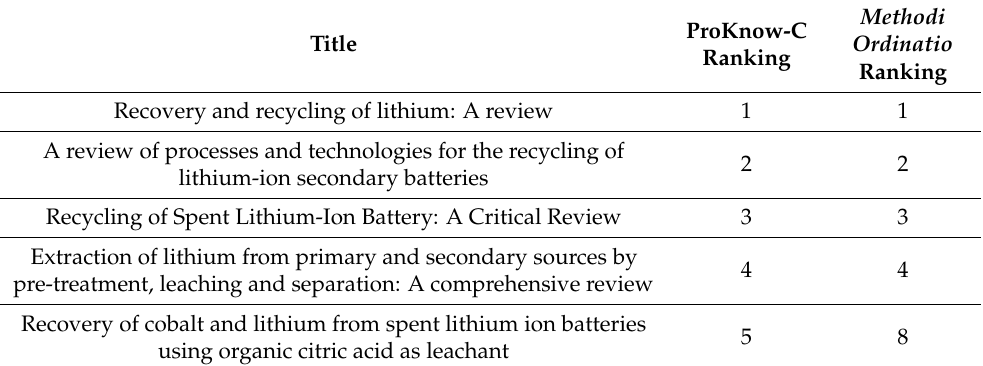
Table 6. Rank comparisons between ProKnow-C and Methodi Ordinatio